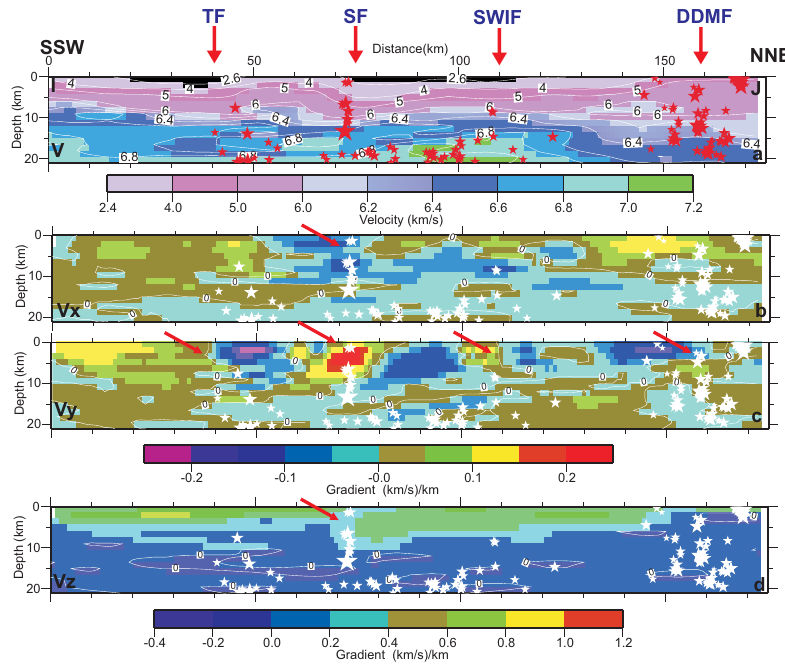
Fig. 6. Profile IJ. Vertical cross-section of (a) tomographic velocity model (b) X gradient of velocity model, (c) Y gradient of velocity model, and (d) Z gradient of velocity model. Abbreviations as in Fig. 1.